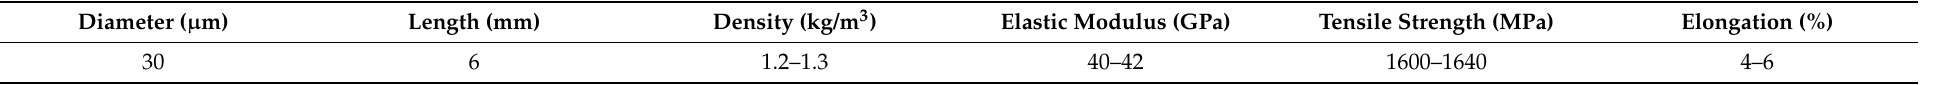
Table 2. Main properties of the PVA